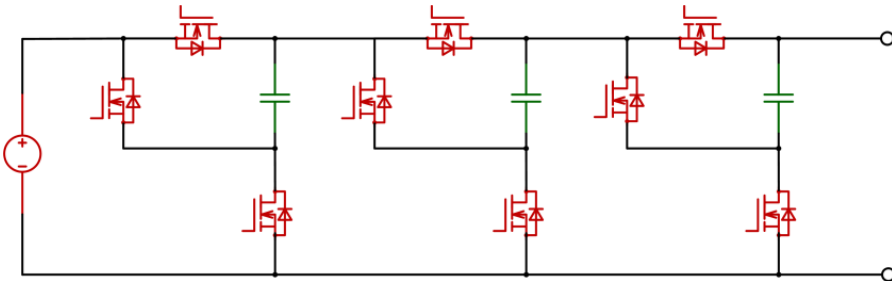
Figure 8. The circuit topology of switched-capacitor DC/DC